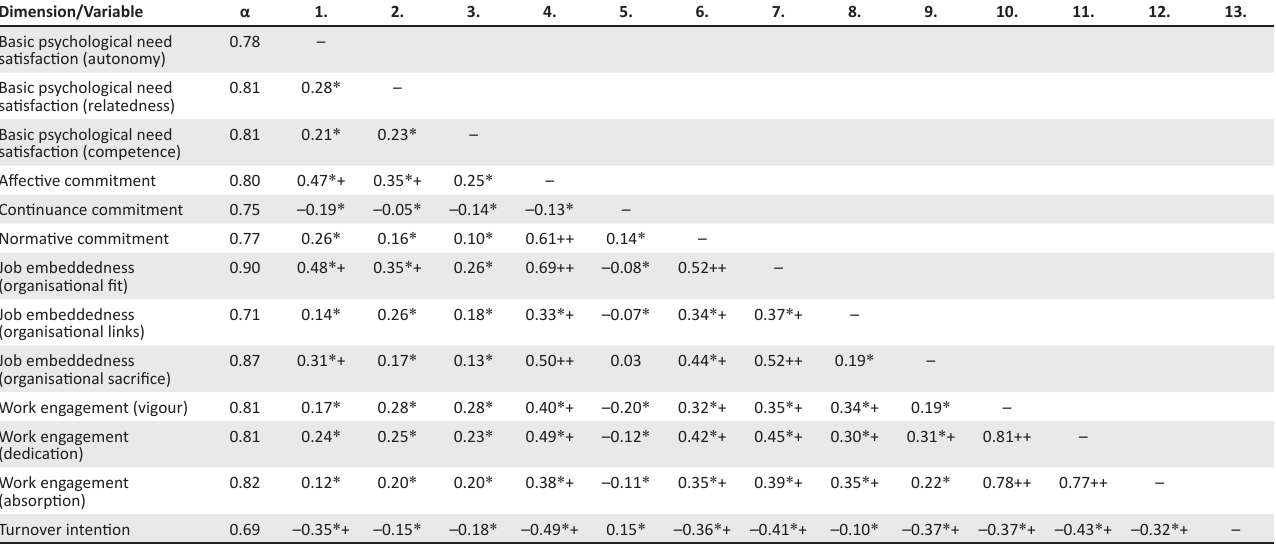
TABLE 2: Descriptive statistics and Pearson’s correlation